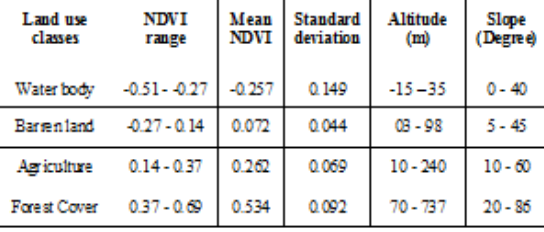
Table 2. NDVI, altitude and slope of some LULC classes